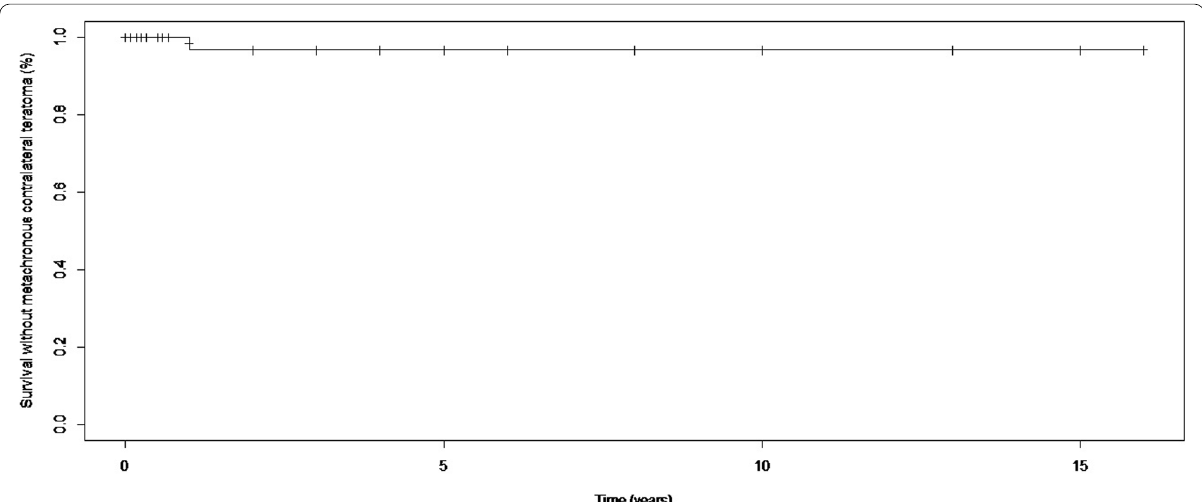
Fig. 1 Kaplan–Meier survival analysis. The percentage of patients identified as having no metachronous contralateral teratoma on follow-up imaging is plotted on the y -axis against follow-up time in years on the x -axis. Censored patients (no further follow-up) are demonstrated as perpendicular marks on the plotted